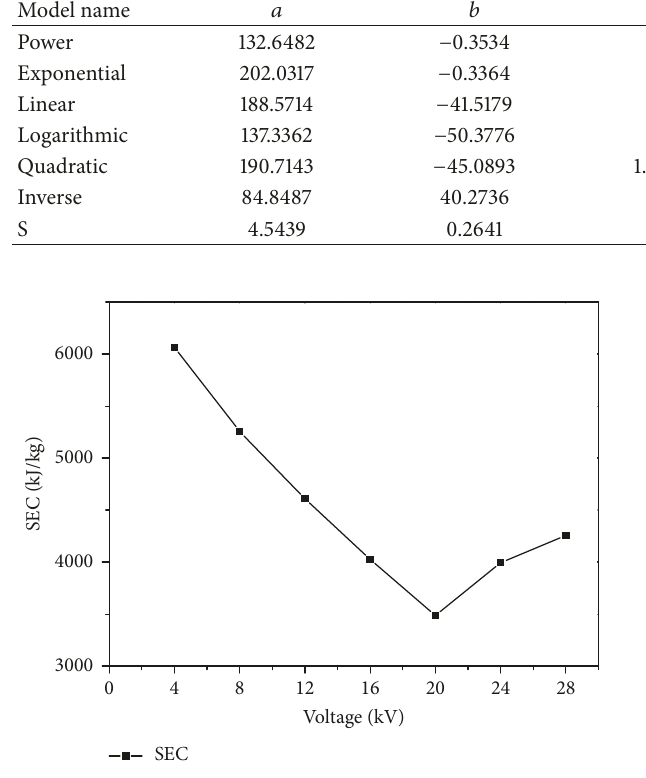
Figure 4: Effects of voltage on special energy consumption of tofu.